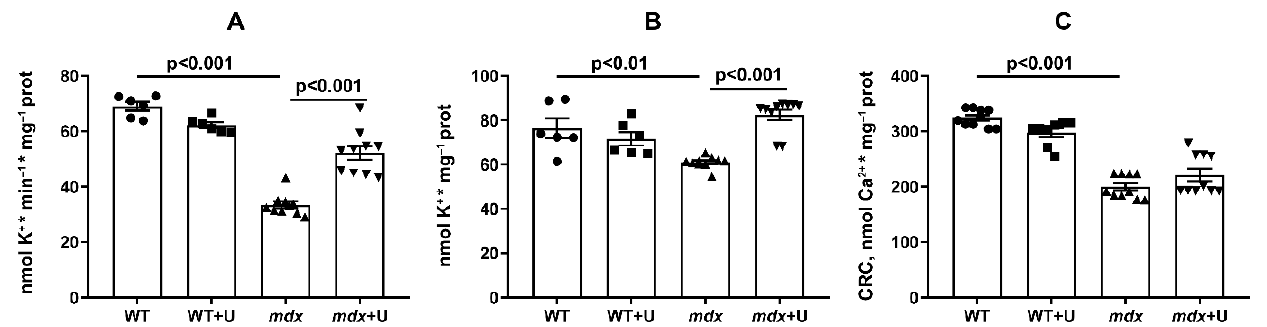
Figure 8. Assessment of the transport and level of potassium and calcium ions in the skeletal muscle mitochondria of mice in the experimental groups. The rate of the DNP-induced release of K + from the skeletal muscle mitochondria of experimental animals ( A ). The total content of K + in the skeletal muscle mitochondria of experimental animals ( B ). Ca 2+ retention capacity of the skeletal muscle mitochondria of the experimental animals ( C ). The data are presented as means ± SEM ( n = 6 – 10).